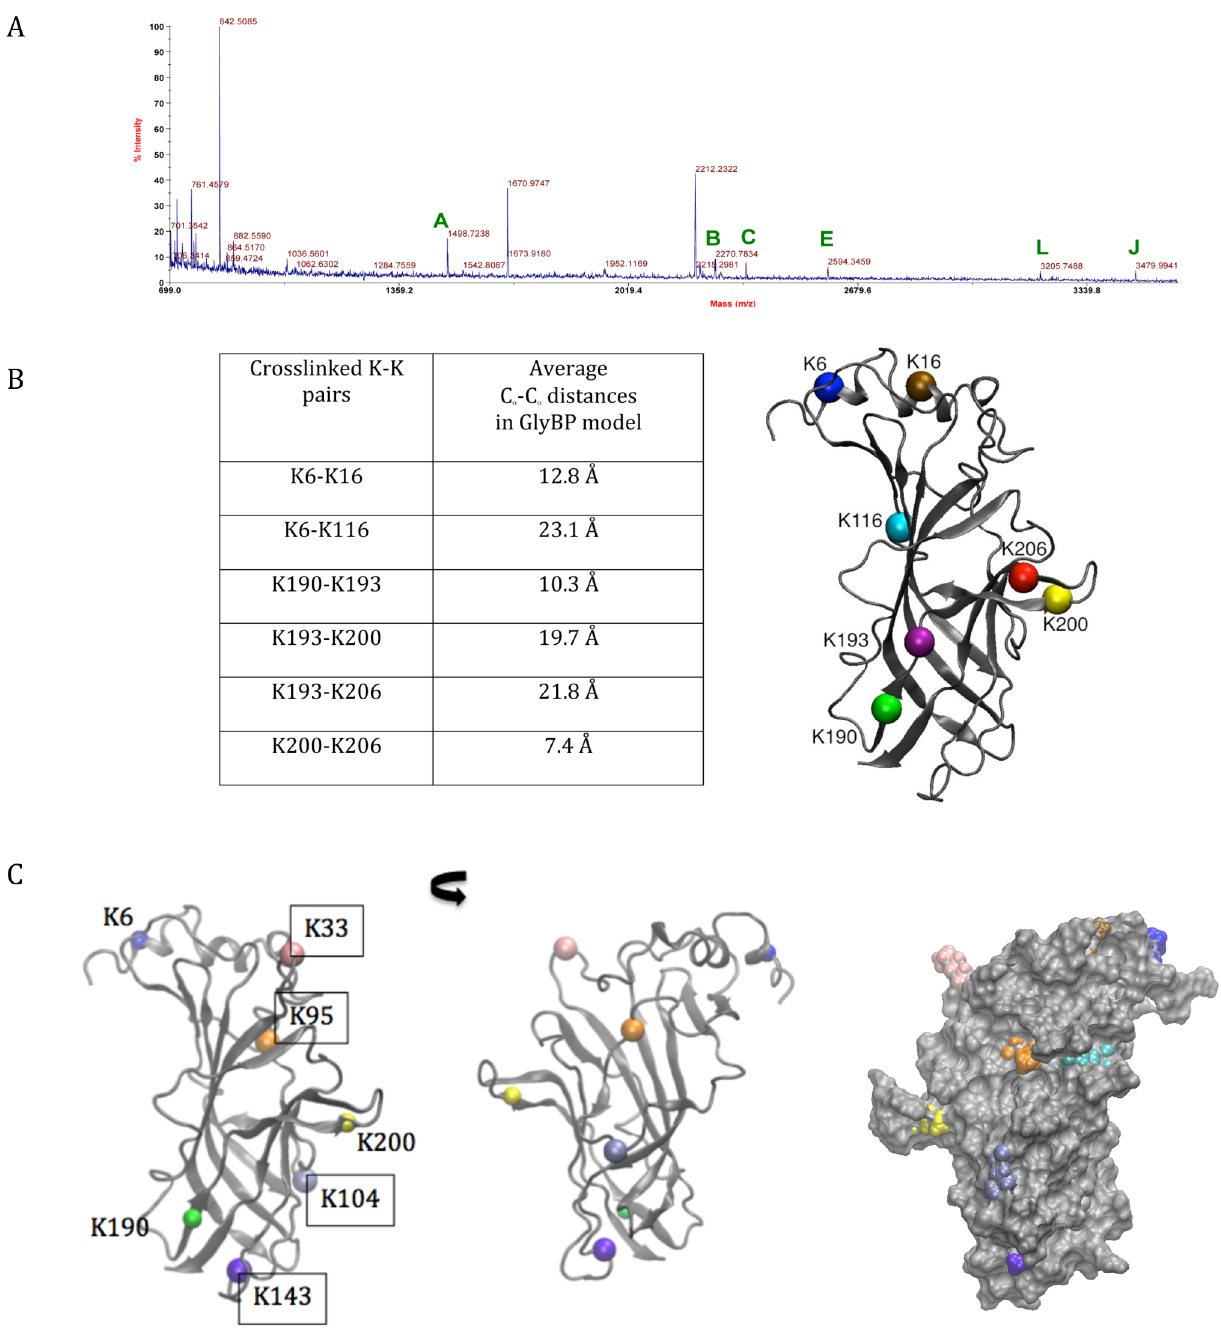
Figure 4. Intramolecular crosslinks observed in GlyBP by MALDI-TOF MS analysis after crosslinking with DMS. A) Representative mass spectrum of tryptic digest of excised monomeric GlyBP band. Mass peaks assigned as crosslinked peptides are labeled and further identified in Table 1 . B) Average C a -C a Lys-Lys distances measured along the MD trajectory of assigned crosslinks are provided in the panel below. The calculation of distances is averaged over all 5 subunits/interfaces over the 2 ns long MD trajectory. The positions of the Lys residues in the modeled GlyBP (for simplicity, only the monomer is represented) are shown. The protein structure is shown in grey color in cartoon representation and C a atoms of Lys residues are shown as colored spheres. C) The positions of Lys residues in the model of GlyBP for which we did not observe crosslinking (residue numbers in boxes): the panel shows the outer surface and the inner surfaces of a subunit - the latter also represented by space-filled model.